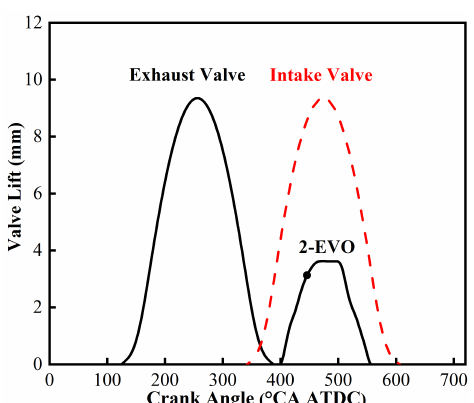
Fig. 3 Valve lift